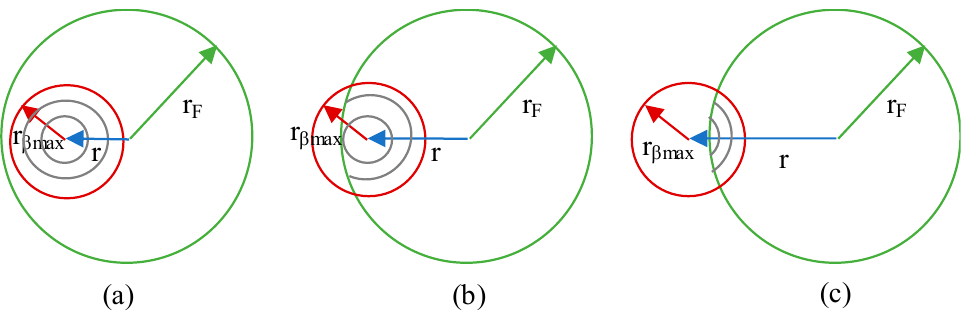
Figure 3. Case I integration sequence as r increases ( a ) only circumferences, ( b ) circumferences and arcs, ( c ) only arcs.